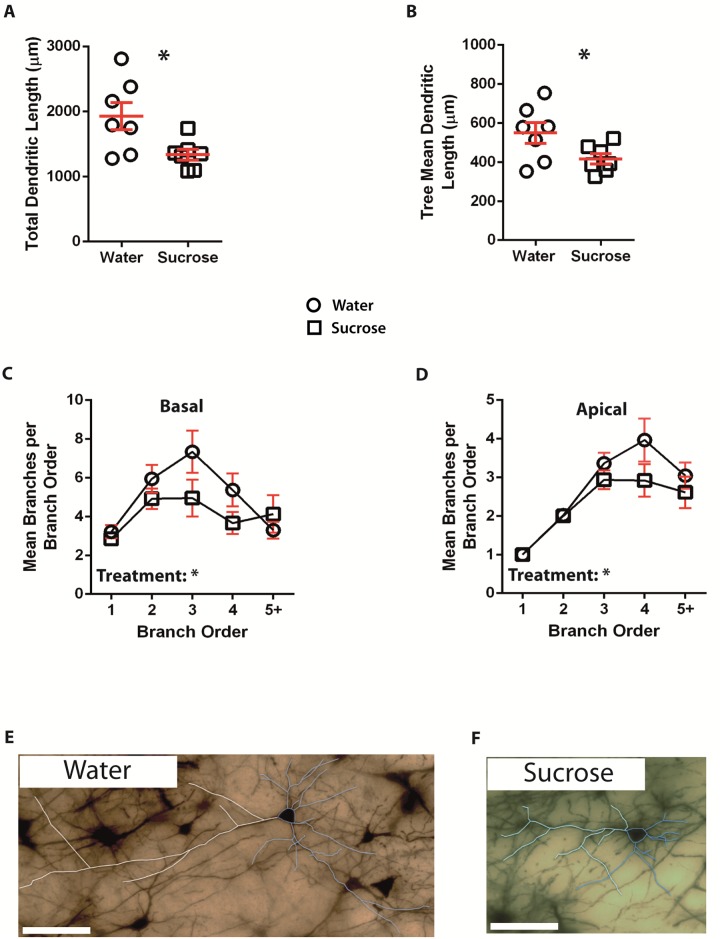
Decreased dendritic arbor length of principal neurons from the basolateral amygdala (BLA) of short-term sucrose consuming rats compared to control rats.A shows a scatter-plot of decreased total dendritic arbor (mean ± SEM) from the BLA in short-term sucrose rats (open squares) compared to controls (open circles) (Unpaired two-tailed Students t-test,*P < 0.05, n = 7; control and n = 7; 4 week sucrose). B shows a scatter-plot of decreased mean dendritic tree length (mean ± SEM) from the BLA in short-term sucrose rats (squares) compared to controls (circles) (Unpaired two-tailed Students t-test, *P < 0.05, n = 7; control and n = 7; 4 week sucrose). Branch order analysis (mean ± SEM) showing decreased number of dendritic segments per branch order for basal dendrites (C) and apical dendrites (D) from sucrose consuming rats (squares) and water control rats (circles) (two-way ANOVAs, n = 7; control and n = 7; short-term sucrose). E and F show representative brightfield z-stack mosaics of Golgi-Cox impregnated principal neurons from the BLA (63x magnification) of control (water) and short-term (4 week) sucrose drinking rats respectively. Scale Bars: (E, F) = 100 μm.